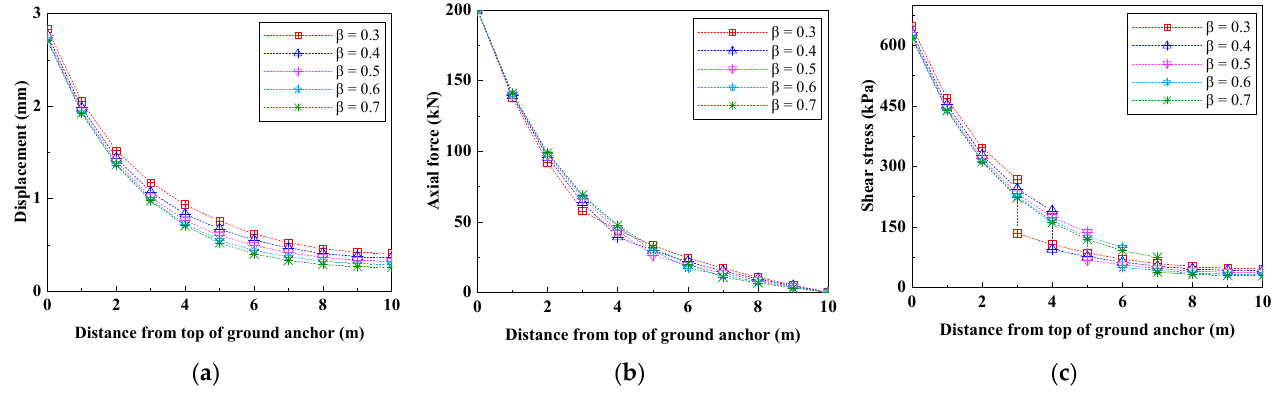
Figure 9. Effect of the depth of stratum interface on mechanical behavior of ground anchor. (Case 1: condition 4) ( a ) displacement distribution curve; ( b ) axial force distribution curve; ( c ) shear stress distribution curve.